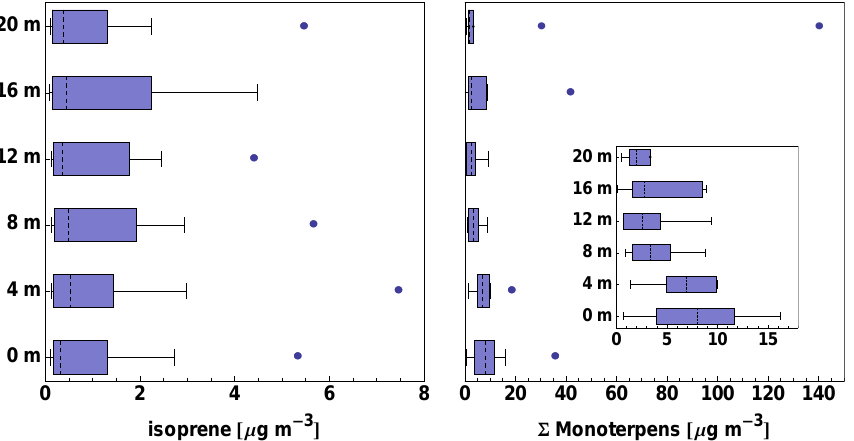
Fig. 4. Variation of isoprene and total monoterpene ambient air concentrations measured over the whole year. The boxes, ranging from the 0.25 to the 0.75 quartile, cover 50% of the data, the dashed lines denote the median concentration and the whiskers show the standard deviation of the data excluding far outliers. Outliers are given as dots and mark in both cases the measurements in July 2010 with exceptional high temperatures. The inset in the monoterpene plot show the shape of the boxes and the location of the median concentrations in